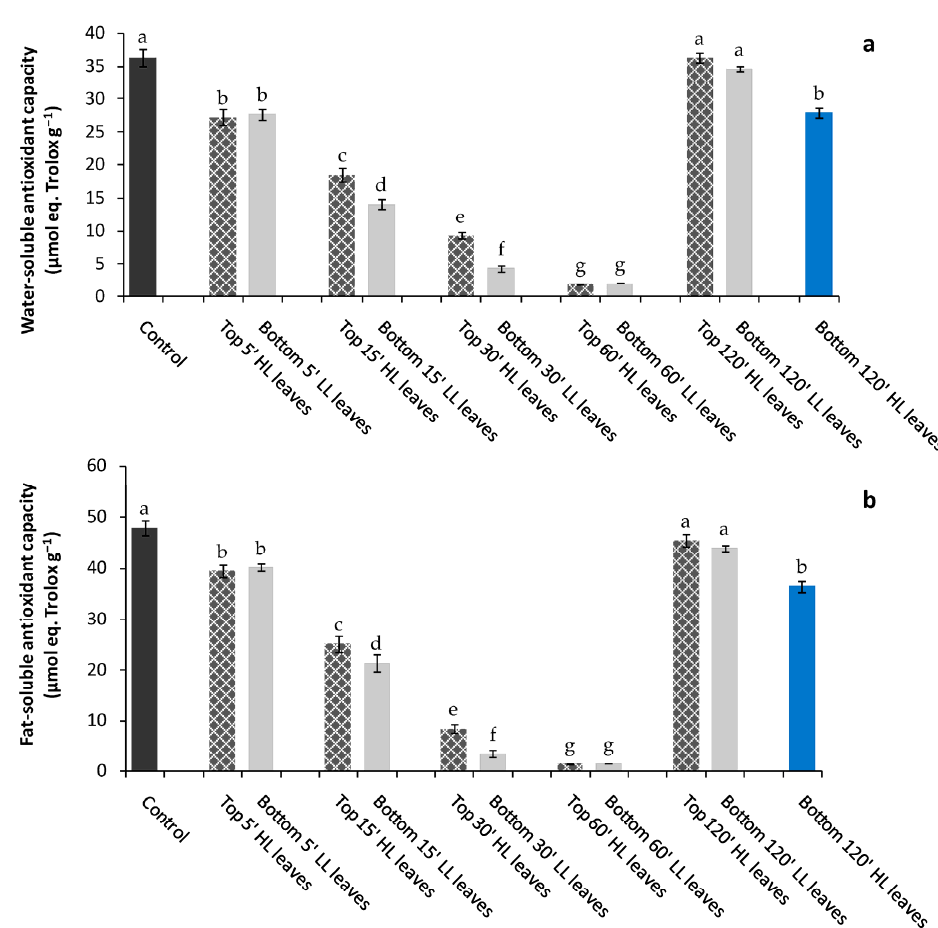
Figure 4. Water-soluble ( a ) and fat-soluble ( b ) antioxidant capacity in P. vulgaris L. Control, Top 5’, 15’, 30’, 60’, and 120’ HL leaves (inducing stressed after 5’, 15’, 30’, 60’, and 120’ of light stress), Bottom LL leaves (receiving unstressed) and Bottom 120’ HL leaves (receiving leaves after 120’ of light stress). Different letters indicate statistically significant difference among treatments ( p ≤ 0.05) by One-Way ANOVA followed by Holm–Sidak post-hoc test.